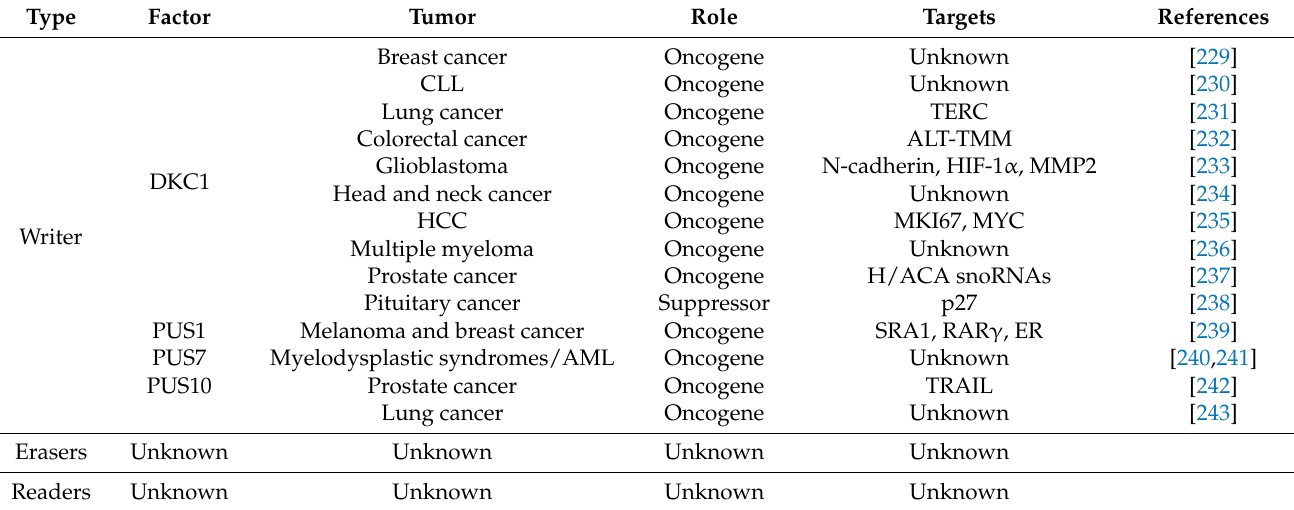
Table 5. Role of pseudouridylases in cancer. DKC1—dyskerin pseudouridine synthase 1;